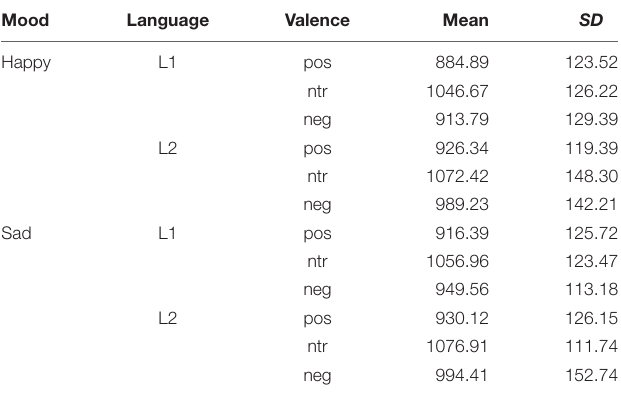
two categories not differing. Reaction times for the individual experimental conditions are detailed in Table 5